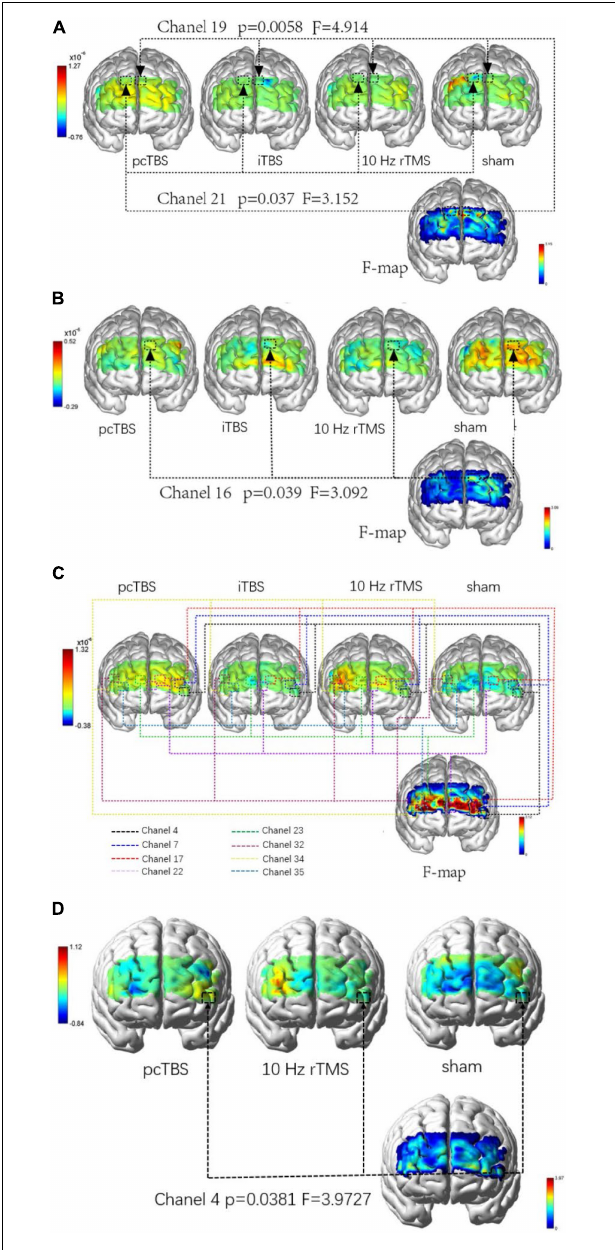
FIGURE 6 | (A) Comparison of difference in brain activation when performing PTT 2,000 Hz task immediately after stimulation. (B) Comparison of difference in brain activation when performing PTT 5 Hz task immediately after stimulation. (C) Comparison of difference in brain activation when performing PTT 2,000 Hz task 1 h after stimulation. (D) Comparison of difference in changes between 1 h after stimulation and baseline in brain activation when performing PTT 2,000 Hz. pcTBS, prolonged continuous theta-burst stimulation; iTBS, intermittent theta-burst stimulation; rTMS, repetitive transcranial magnetic